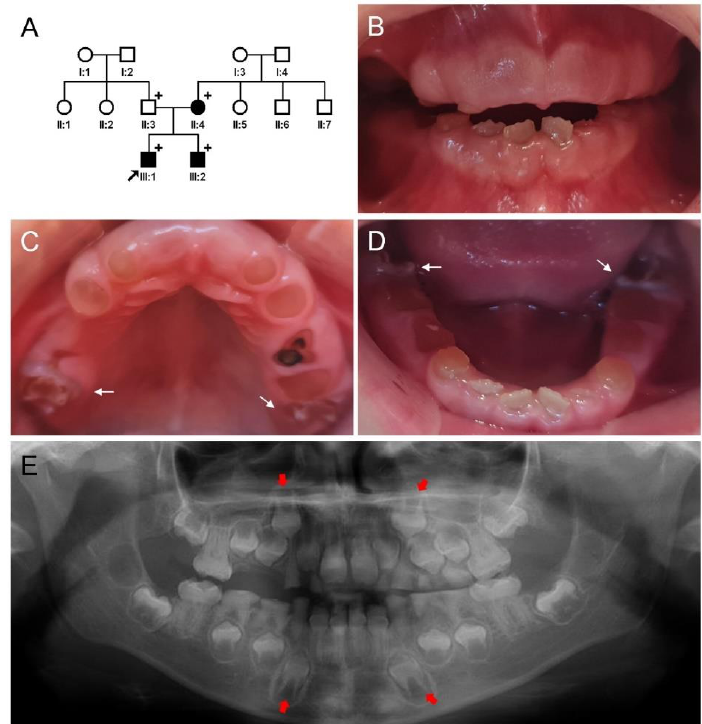
Figure 1. Pedigree, clinical photos, and panoramic radiograph of family 1. ( A ) Pedigree of family 1. Black symbols indicate affected individuals and the proband is indicated by a black arrow. Plus signs above the symbols indicate participating individuals. ( B – D ) Clinical photos of the proband (III:1) at age 8. Weak deciduous dentition shows severe attrition in most teeth to the level of gingiva. His erupting permanent mandibular anterior teeth exhibit amber − brown discoloration. The first molars (white arrows) show defective enamel formation. ( E ) Panoramic radiograph of the proband at age 8 shows severe attrition and complete pulp obliteration in all deciduous teeth. Enamel defects in the developing dentition, especially in the maxillary and mandibular canines (red arrows), can be seen